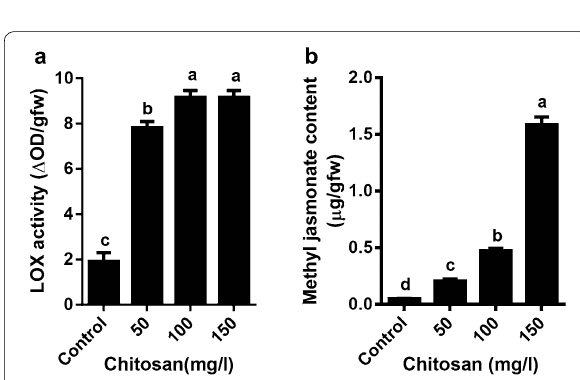
Fig. 5 Effect of chitosan levels on lipoxygenase activity ( a ) and methyl jasmonate content ( b ) of Melissa officinalis shoot cultures. Each value is expressed as mean standard deviation. Differences ± were significant at p < 0.05 level (one-way ANOVA followed by LSD test)